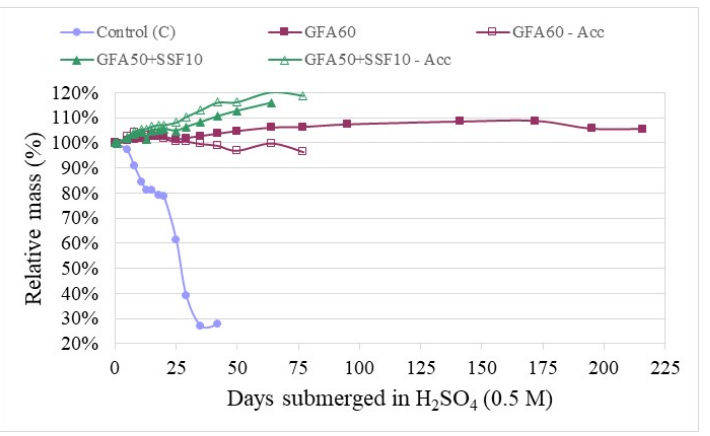
Figure 13. Mass variation for the GRC composites immersed in a 0.5 molar (0.5 M) H 2 SO 4 solution.